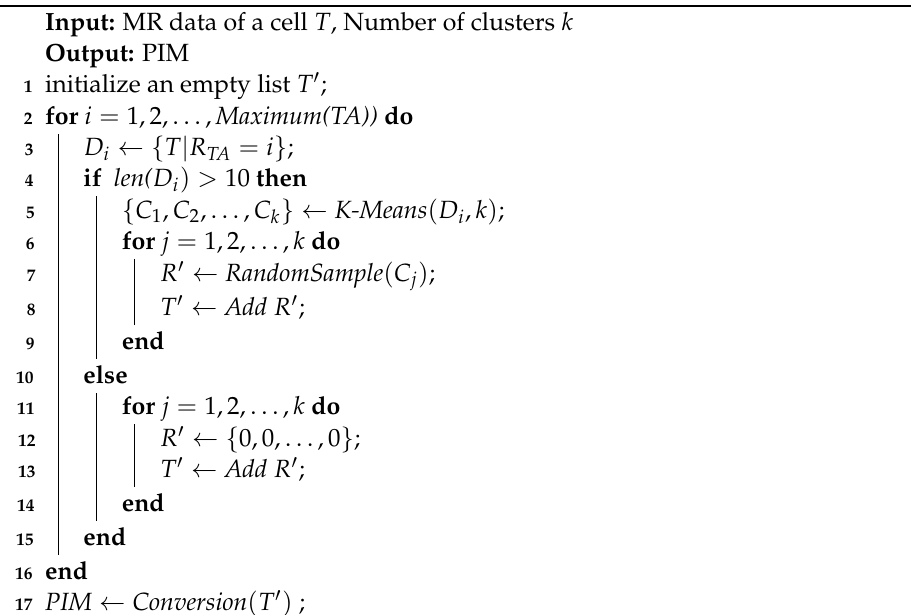
Algorithm 1: Representation method for MR